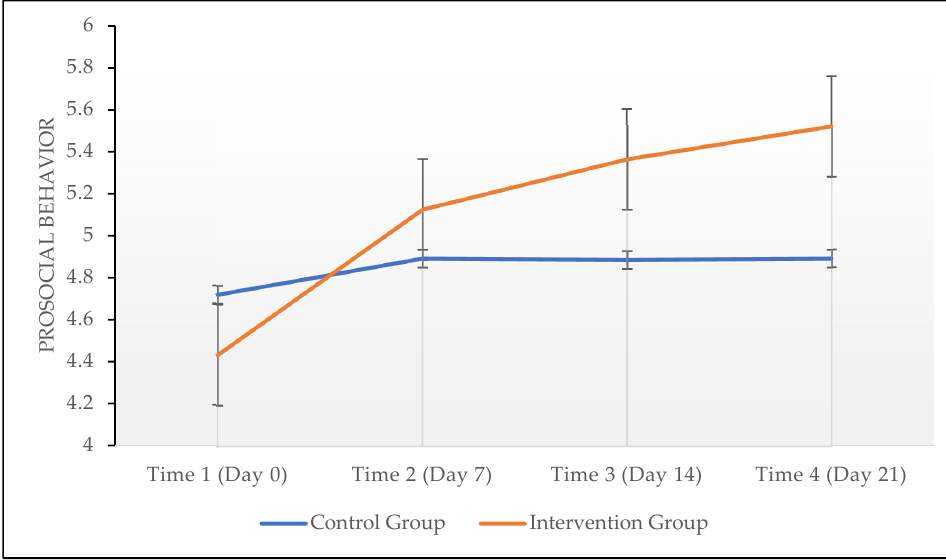
Figure 2. Effects of repeated measures on prosocial behavior. Error bars represent the 95% confi- dence interval.